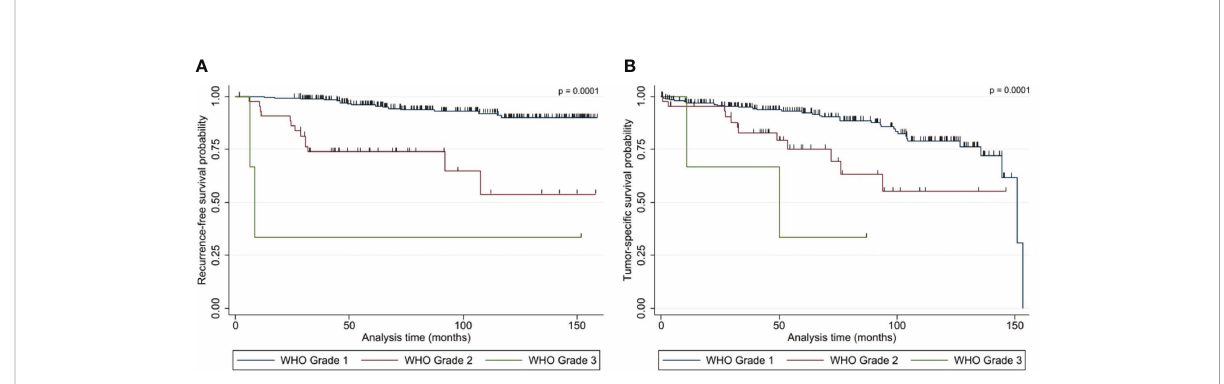
FIGURE 4 Kaplan-Meier plots show the (A) recurrence-free survival and (B) overall survival of patients with NSBM following tumor resection based on WHO grading (n=300). P-values (log rank test) are